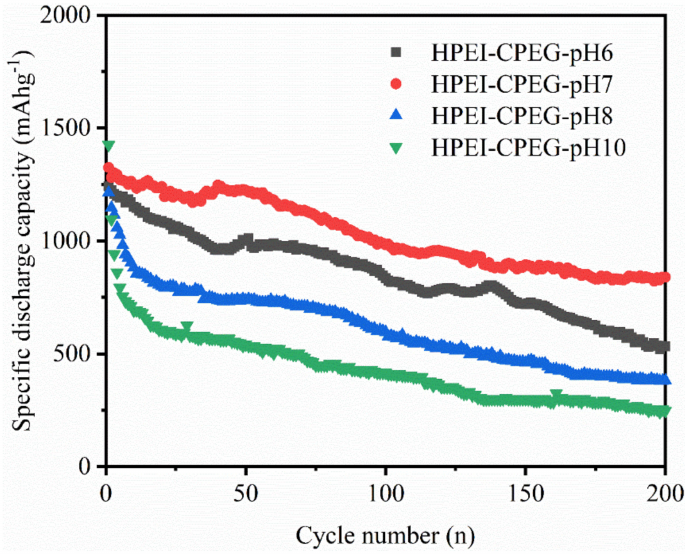
Figure 6. Discharge capacities Si anode with HPEI-CPEG-pH6, HPEI-CPEG-pH7, HPEI-CPEG-pH8, and HPEI-CPEG-pH10 binders as a function of cycle